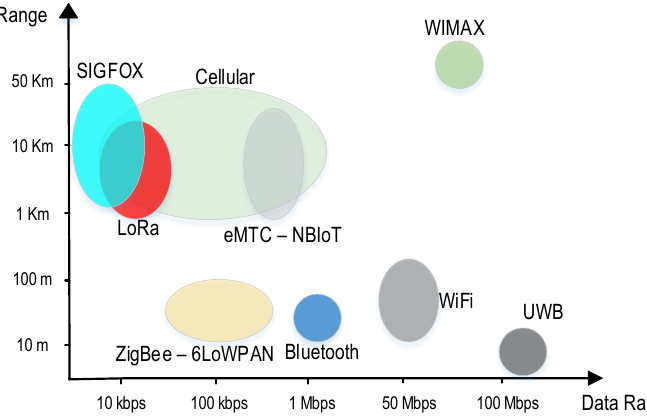
Figure 3. Comparison of different wireless technologies based on range and data rate.